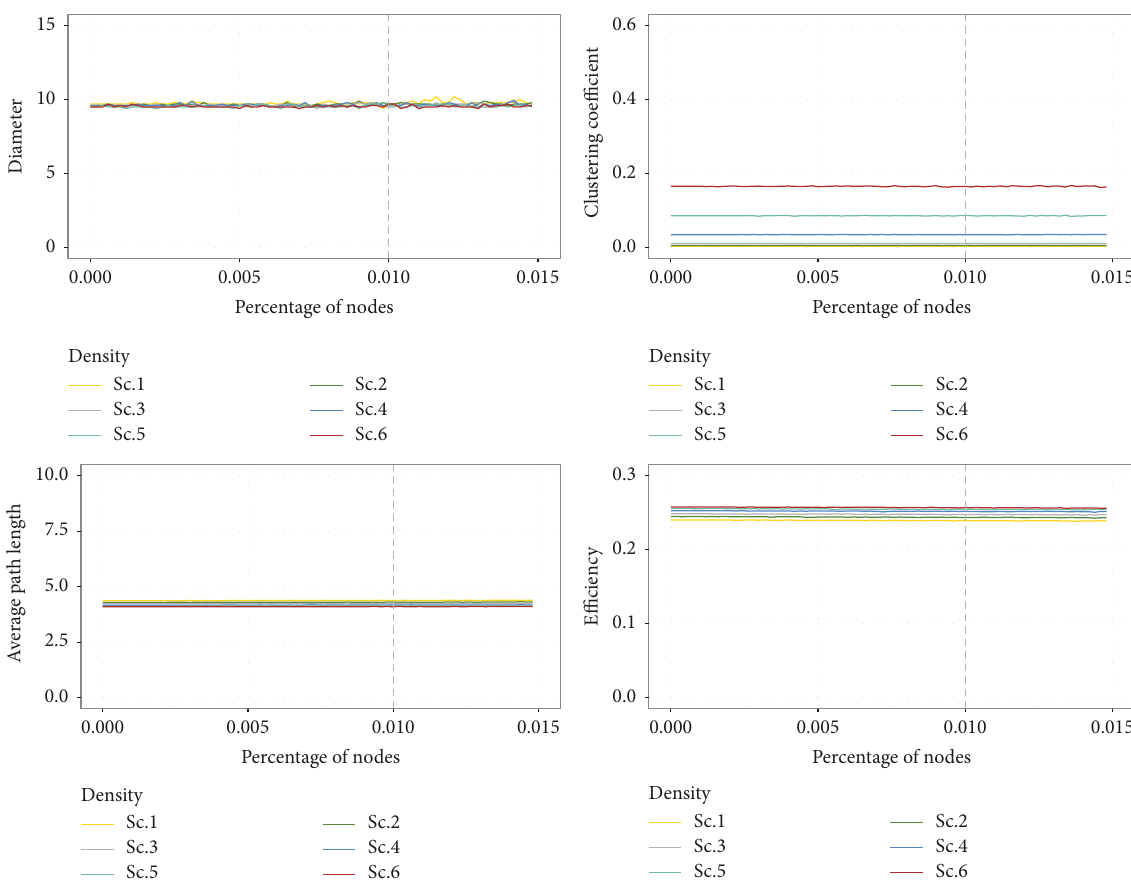
Figure 6: Resilience for simultaneous error simulations with progressive manipulation of the number of links in the network core; magnification of the area of Figure 5 in which the rich-club lays. The dashed line is placed in correspondence with the rich-club size. All results are averaged over 10